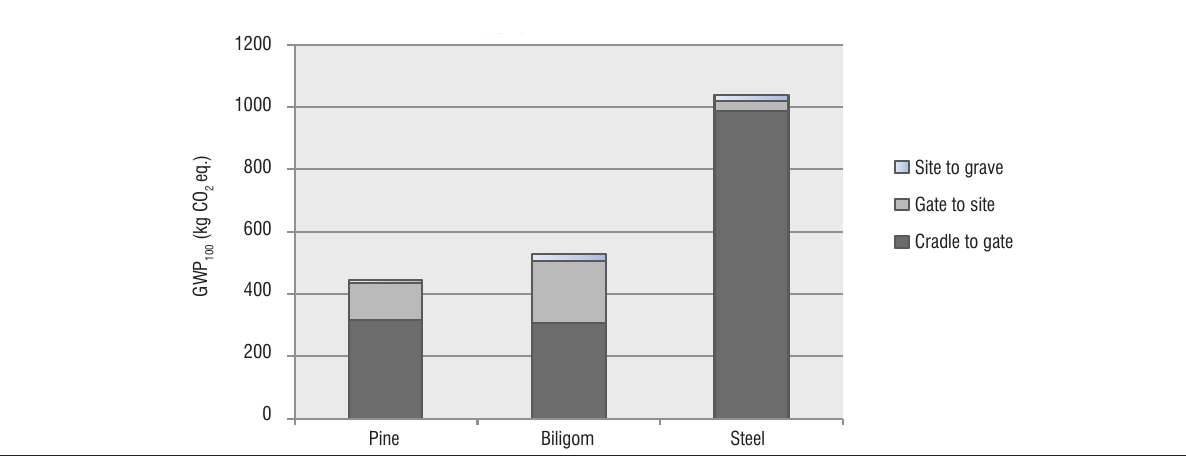
Figure 3: Global warming potential (GWP), excluding biogenic carbon monoxide, carbon dioxide and methane impact per life-cycle stage for the 42-m 2 roof design.